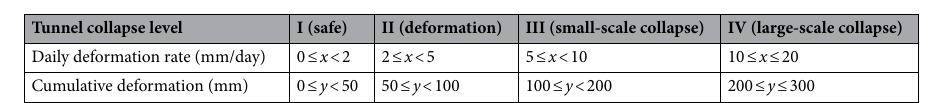
Table 4. Classified states of monitoring measurement data.